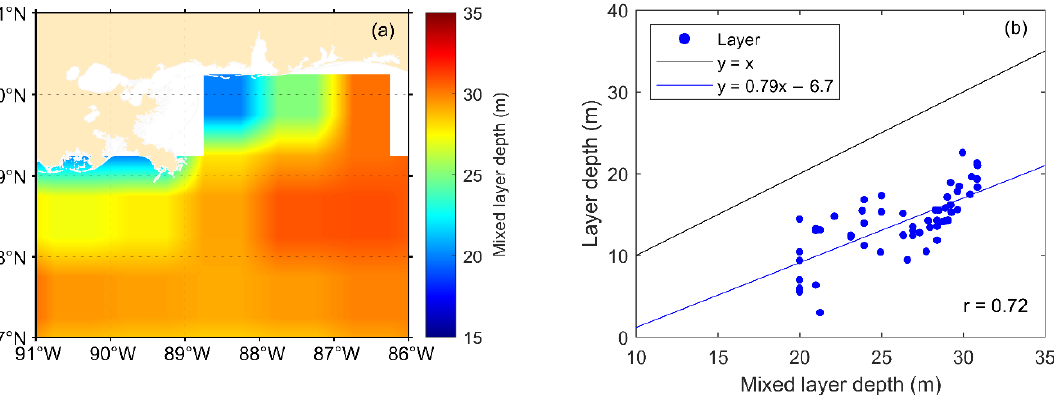
Figure 9. Mixed layer depth and thin layer depth. ( a ) Daily mean mixed layer depth in the Gulf of Mexico on 29 September; ( b ) Statistical analysis of layer depth and mixed layer depth.